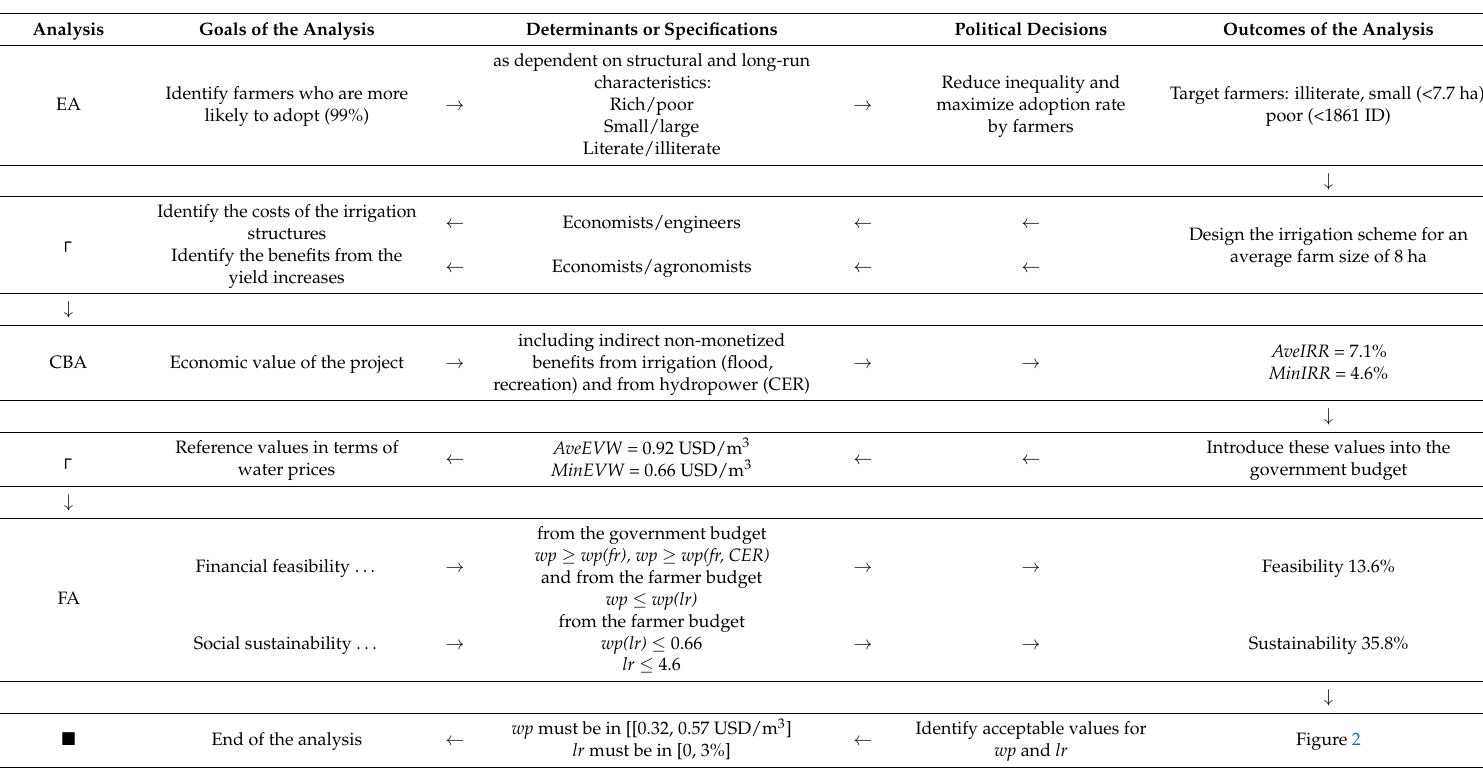
Table 6. Conceptual flow chart of the innovative framework in the present study. Innovative theoretical features are boldfaced. EA, econometric analysis; CBA, Table 9. The conceptual flow chart of the innovative methodological procedure. EA, econometric analysis; CBA, cost–benefit analysis; FA, financial analysis; cost–benefit analysis; FA, financial analysis; IB, indirect benefits; EVW, economic value of water. ID, Iraqi Dinars; CER, certified emission reduction. Analysis Goals of the Analysis